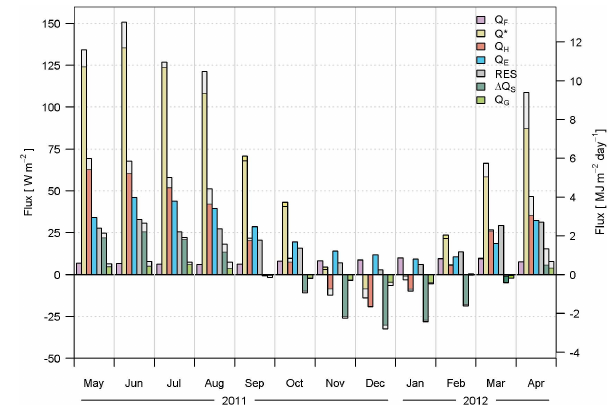
Fig. 4. Monthly mean fluxes (average of 24h ensemble median values for each month) for all available data (coloured bars) and for concurrent data only (unfilled bars). RES denotes the residual ( Q ∗ + Q F ) – ( Q H + Q E ).